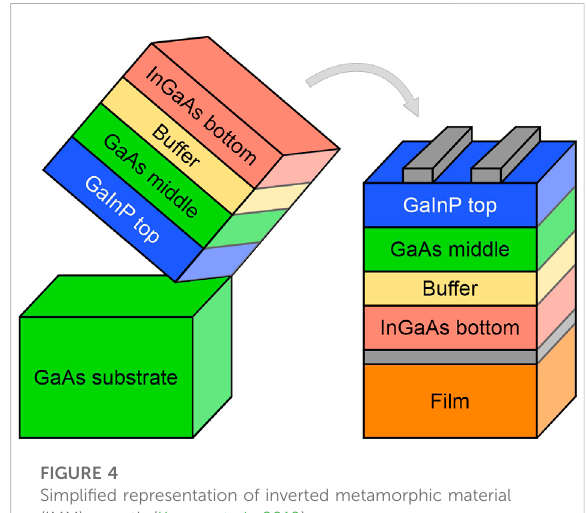
FIGURE 4 Simpli fi ed representation of inverted metamorphic material (IMM) growth (Karam et al.,